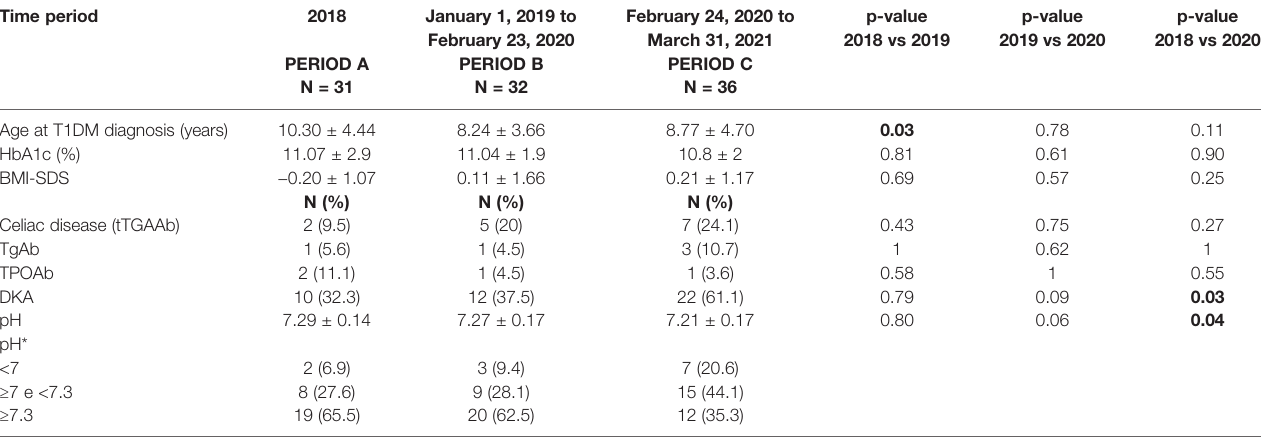
TABLE 1 | Clinical characteristics of the enrolled